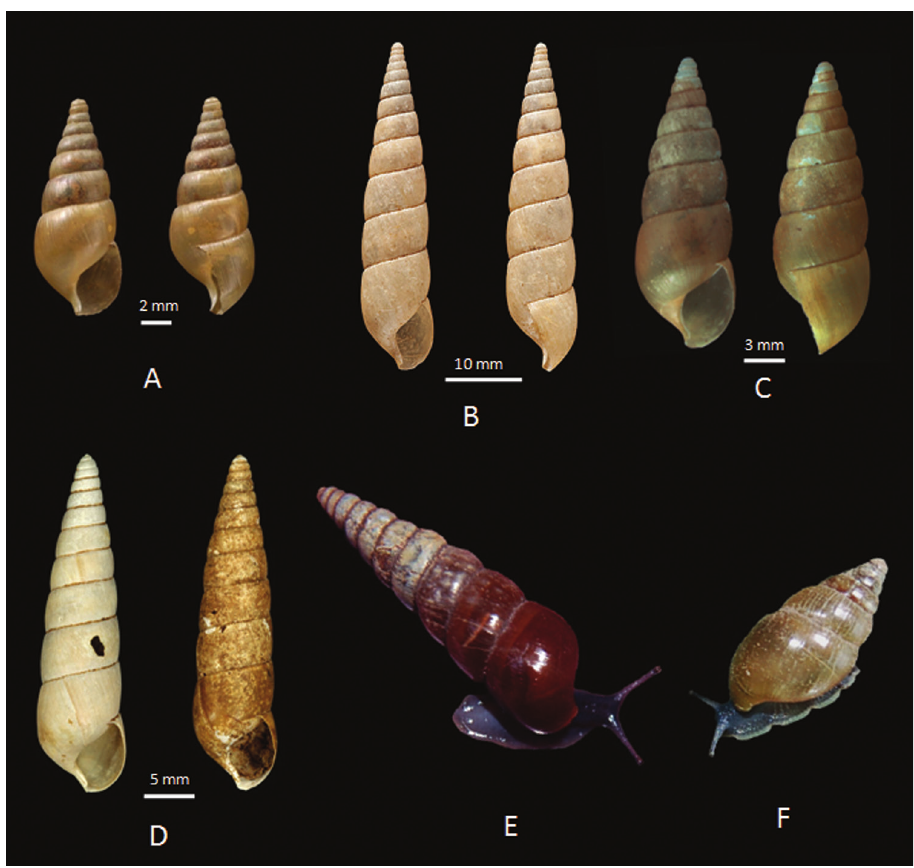
Figure 14. Shells and animals of glessulines. A Achatina tenuispira , possible syntype from ‘Teria Ghat’ labelled as Subulina tenuispira Bens. ZMCU l.102045, Cambridge B Rishetia longispira Godwin-Austen, 1920, 33 syntypes, Rishetchu, Sikkim, NHMUK, Reg. No. 1903.7.1.552 C Rishetia tenuispira , W. Khasi Hills NHMUK, London, Acc. No. 1582.03.VII.I D Two shells of Rishetia kathmandica sp. n. from Ne- pal, previously determined by Schileyko (1999) as Rishetia tenuispira (Benson, 1836) (two lots : Central Nepal, Kathmandu valley, 1.3 km NW from Balaju, Rani-Ban Range, Nagarjun Royal Forest, 1480 m a.s.l., leg./det. A.G. Kuznetsov, 28.04.1995. ZMMU, No. Lc-34221 and 1600–1800 m a.s.l., leg./det. pur F Rishetia mastersi , Kurintar,